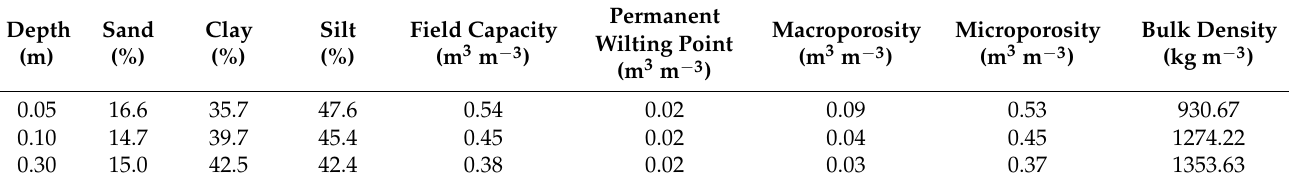
Soil temperature ( T ) was measured with the T108 sensor (Campbell Scientific Inc.,